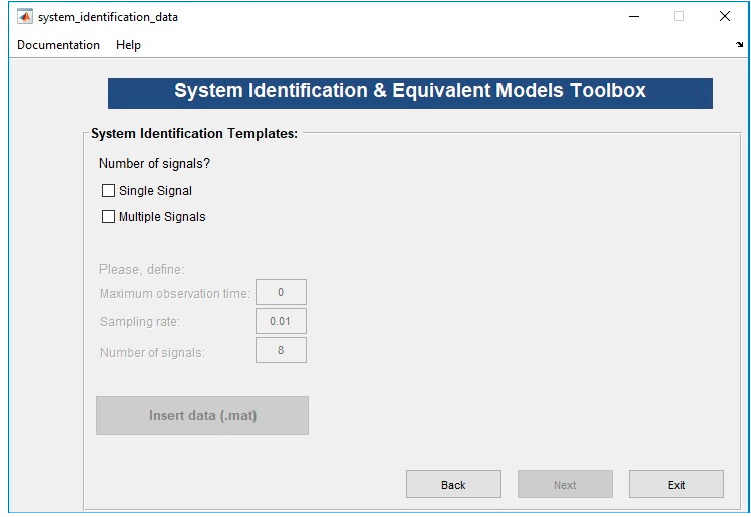
Figure 4. Mode identification techniques data input window.